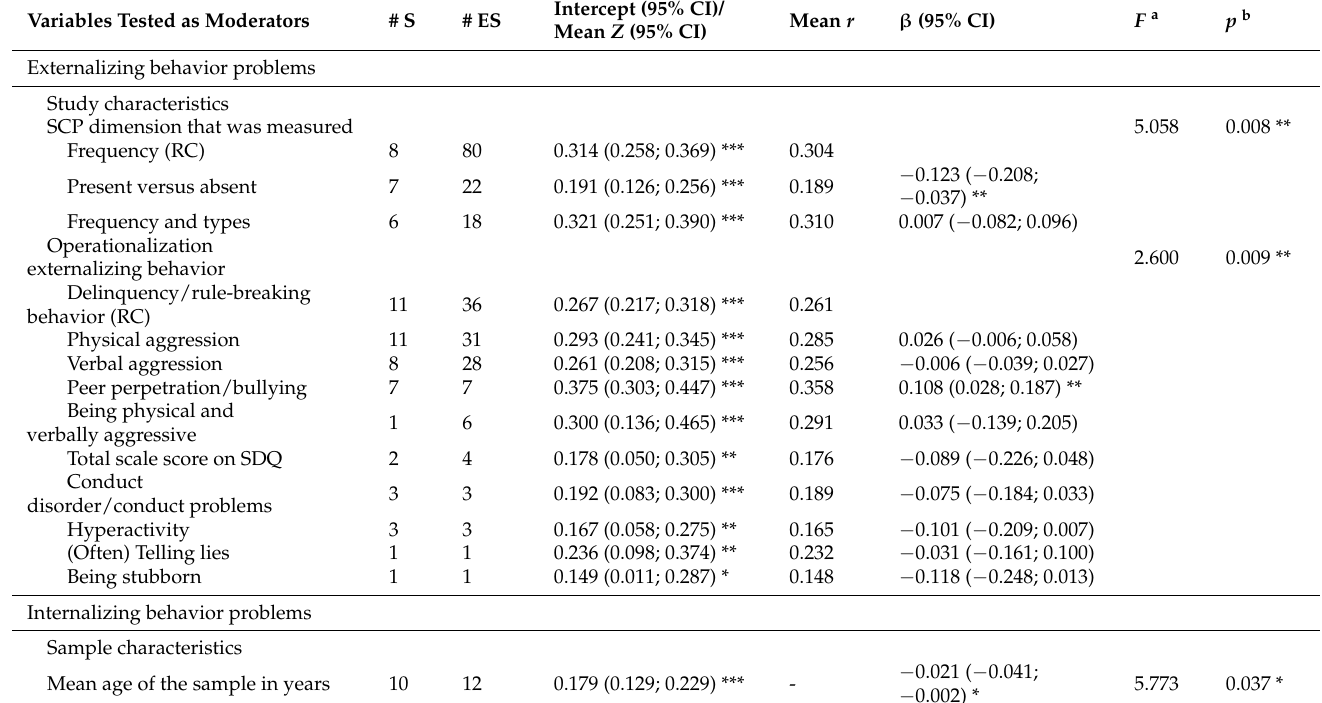
Table 1. Significant Results for Categorical and Continuous Variables Tested as Moderators (in Bivariate